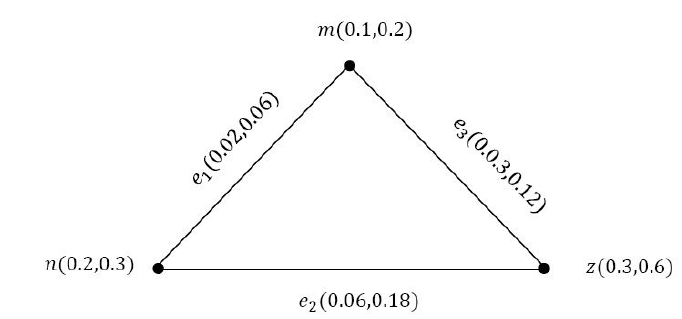
Figure 5. Product vague graph ζ with a dominating set S.